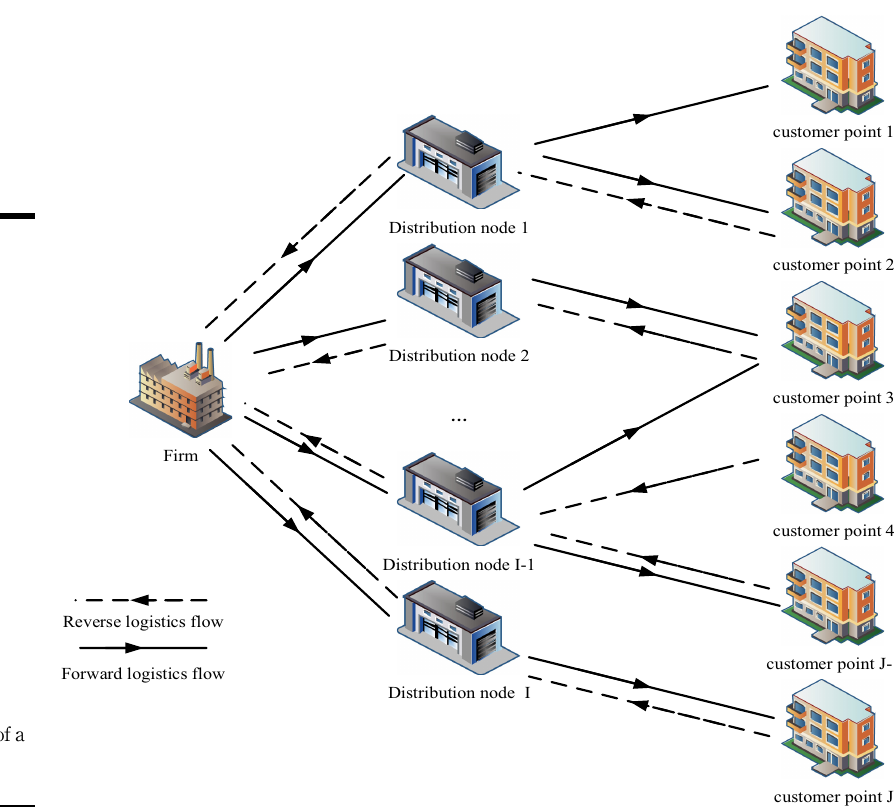
Figure 1. General structure of a closed-loop supply